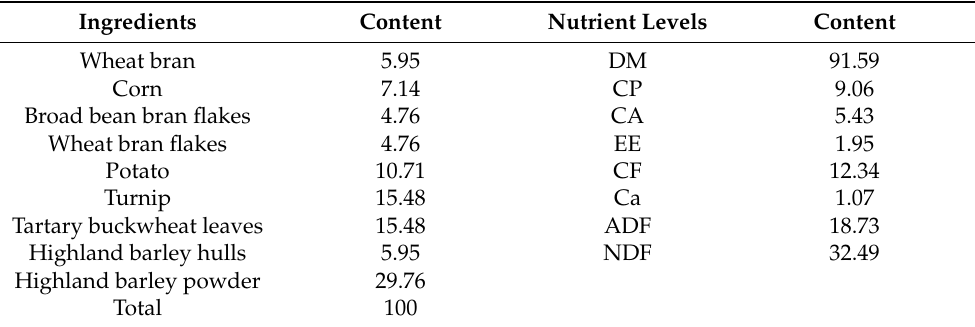
Table 4. Composition and nutrient level of original diet for Diqing Tibetan pigs (April, air-dry basis),